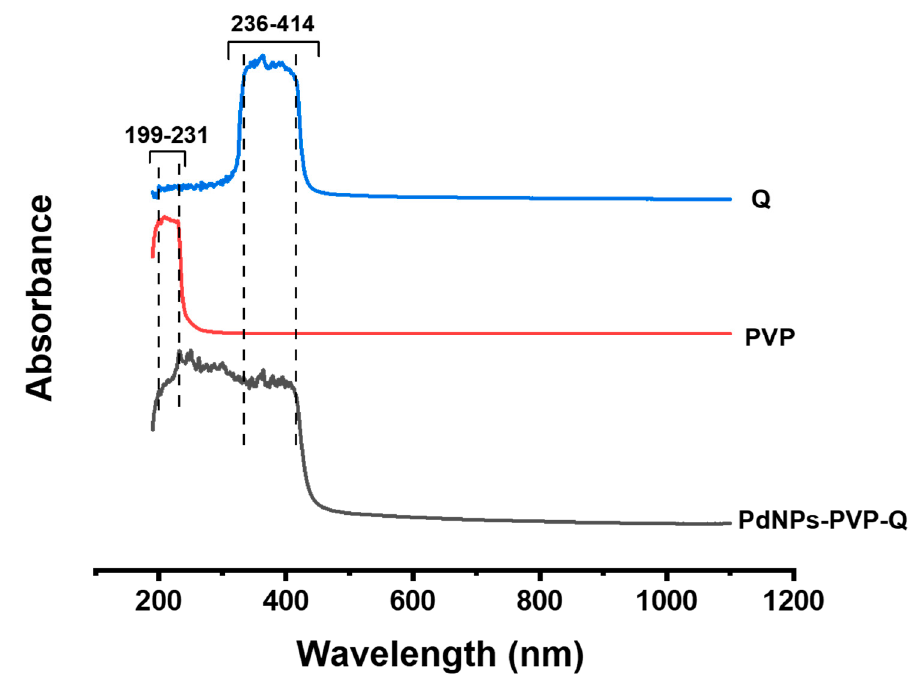
Figure 1. Nanoparticles UV/visible analysis. The absorbance was shown for all the components involved in the functionalization quercetin (Q), polyvinylpyrrolidone (PVP), Pal ‐ ladium nanoparticles (PdNPs) ‐ PVP ‐ Q.